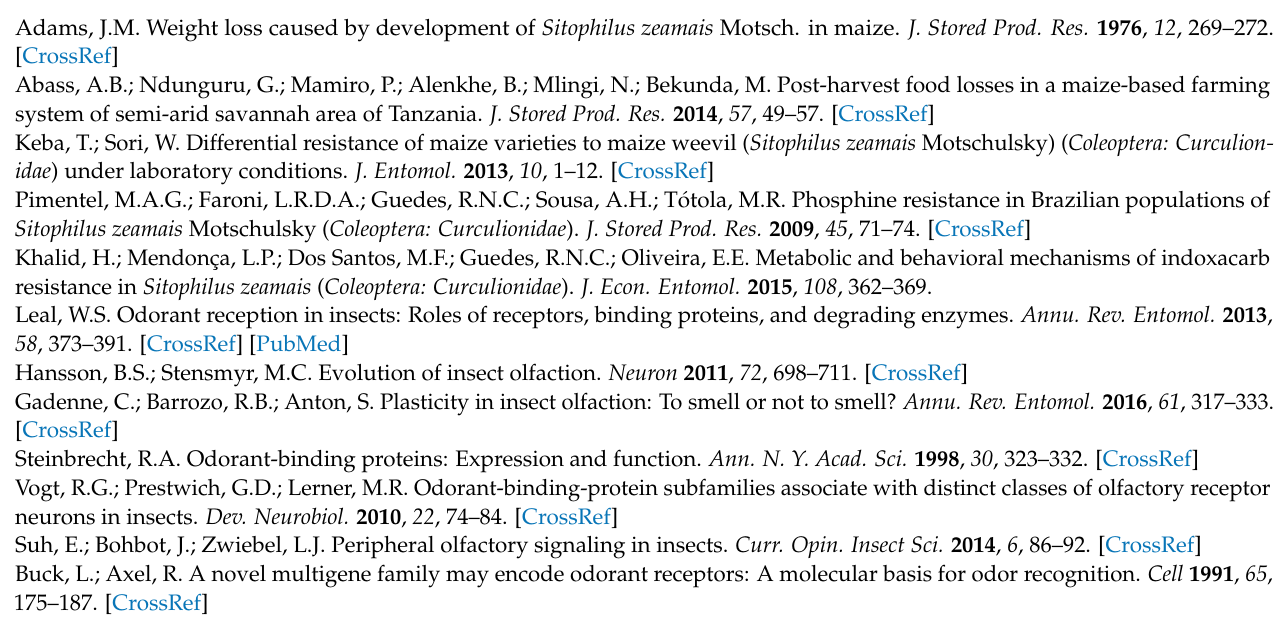
Table S2: The host volatiles used in the substrate competitive experiment. Table S3: The degradation abilities of recombinant SzeaGSTd1 to capryl alcohol, benzaldehyde and vanillin. Figure S1: The relative expression levels of other SzeaGSTs in different tissues. Figure S2: Expression and purification of recombinant SzeaGSTd1. Figure S3: Degradation abilities of recombinant SzeaGSTd1 for capryl alcohol. Figure S4: Degradation abilities of recombinant SzeaGSTd1 for benzaldehyde and